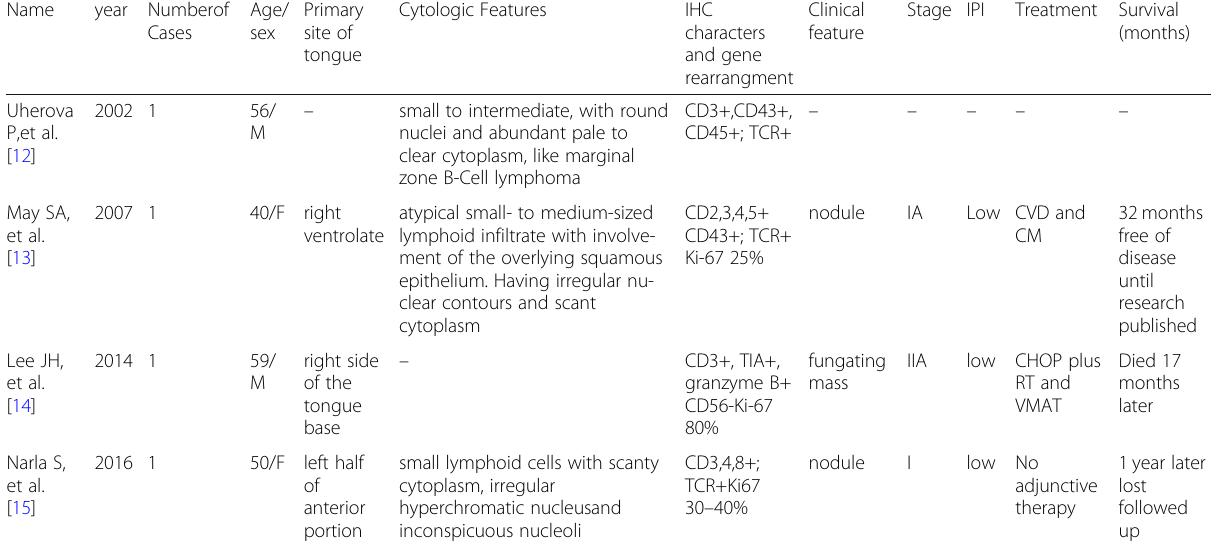
Table 3 Literature review of peripheral T cell